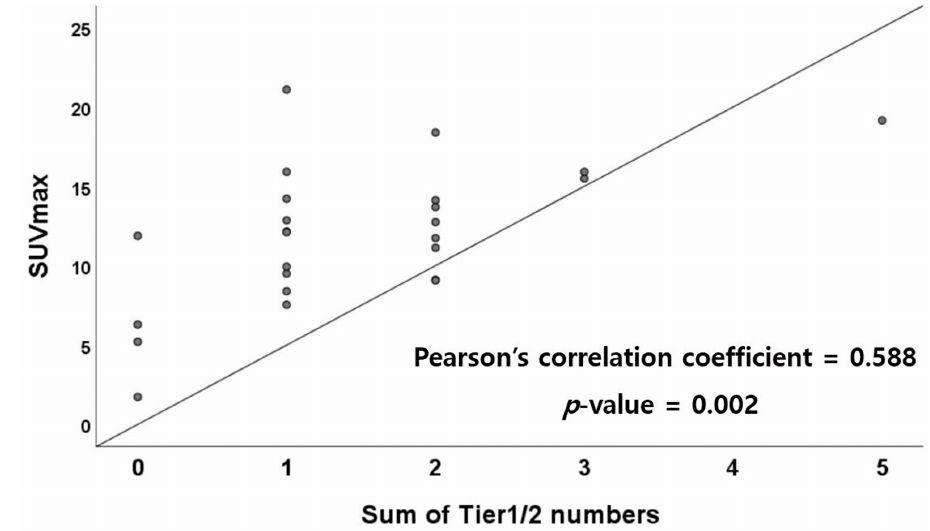
Figure 2. Correlation between the sum of Tier 1 and Tier 2 numbers and SUVmax. Abbreviations: SUVmax, maximum standardized uptake value. Table 3. Frequency of SNV/Indel variants in Tiers 1 and 2 found in NGS